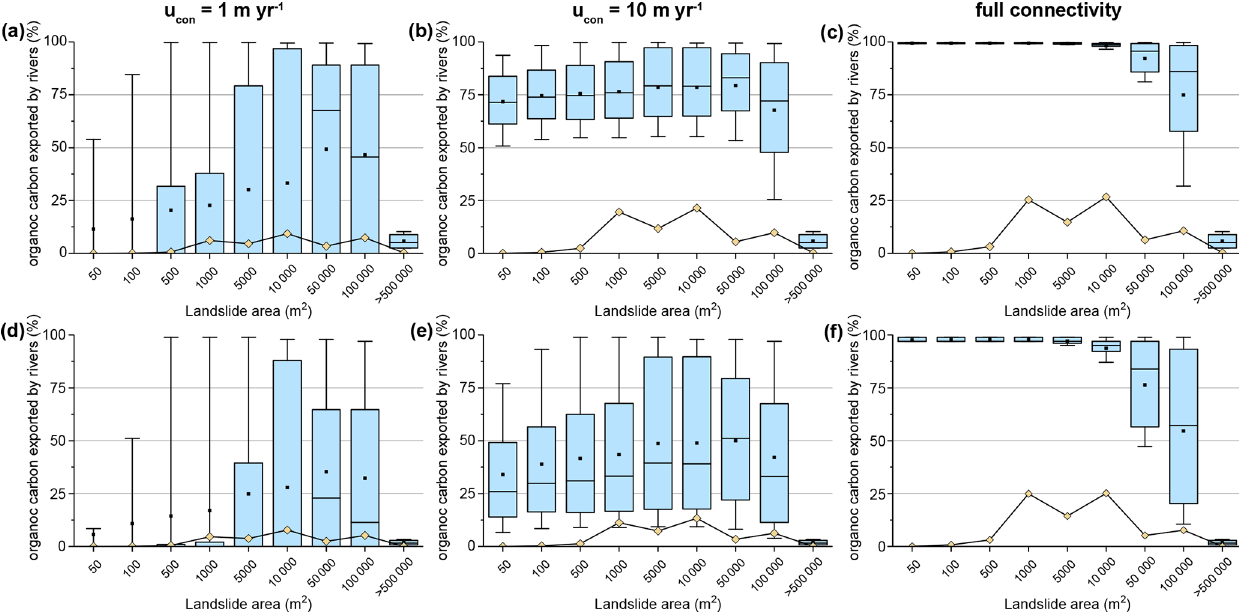
Figure 8. Quantification of the export of OC by river transport for different classes of landslide area (box plots) and for different oxidation constants of the single pool model ( a , b , c : k ox = 0 . 5%yr − 1 ; d , e , f : k ox = 2%yr − 1 ). The yellow diamonds represent the contribution of each landslide area class to the total OC exported by rivers. The boxes show the 25th–75th percentiles, the whiskers show the 10th–90th percentiles, the dot shows the median and the horizontal bar shows the